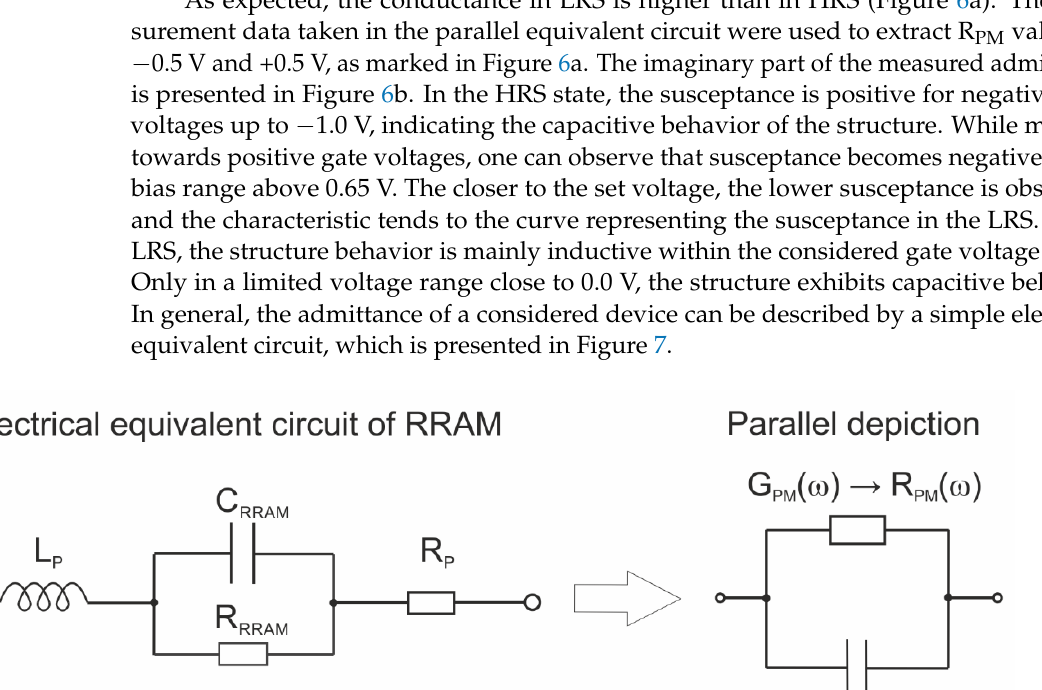
Figure 6. Small-signal admittance components for S1 structure at the frequency f = 100 kHz in different resistance states versus the gate bias voltage. ( a ) conductance; ( b ) susceptance.